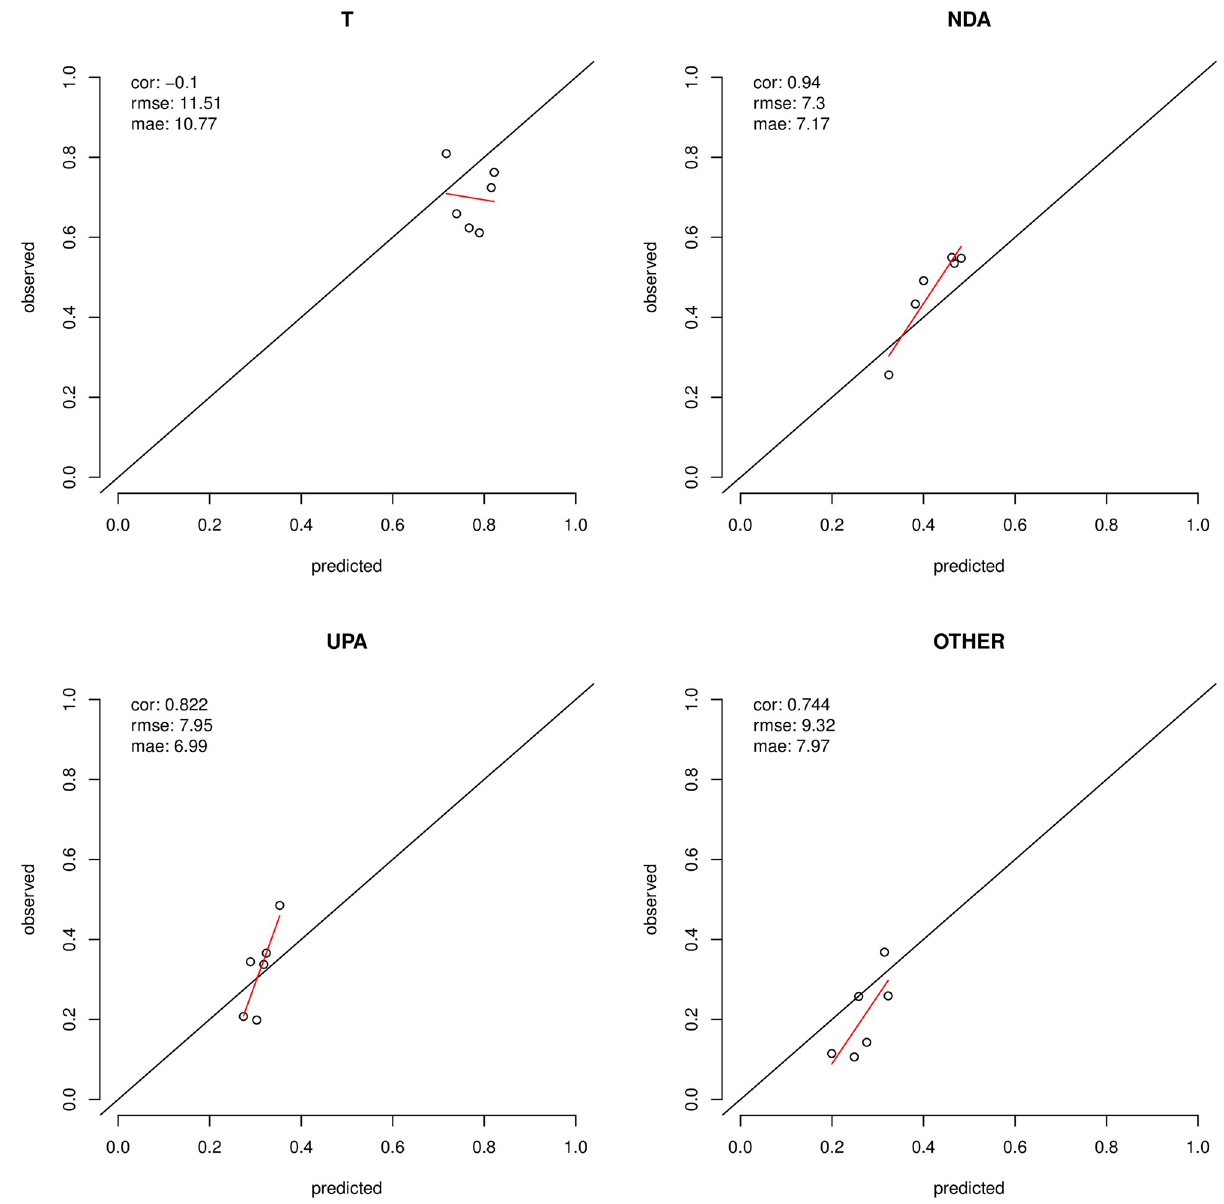
Fig 1. Summary plot assessing the degree of bias, when compared to the estimated stratification frame, across a number of marginal distributions, in each of the three samples used in the analysis. The most severe discrepancies are highlighted. Each dot represents the % of an attribute, such as education level, caste or income, in the population as a whole and in the sample at hand. If the sample at hand is perfectly representative of the population of interest, the dots should lie on the y = x